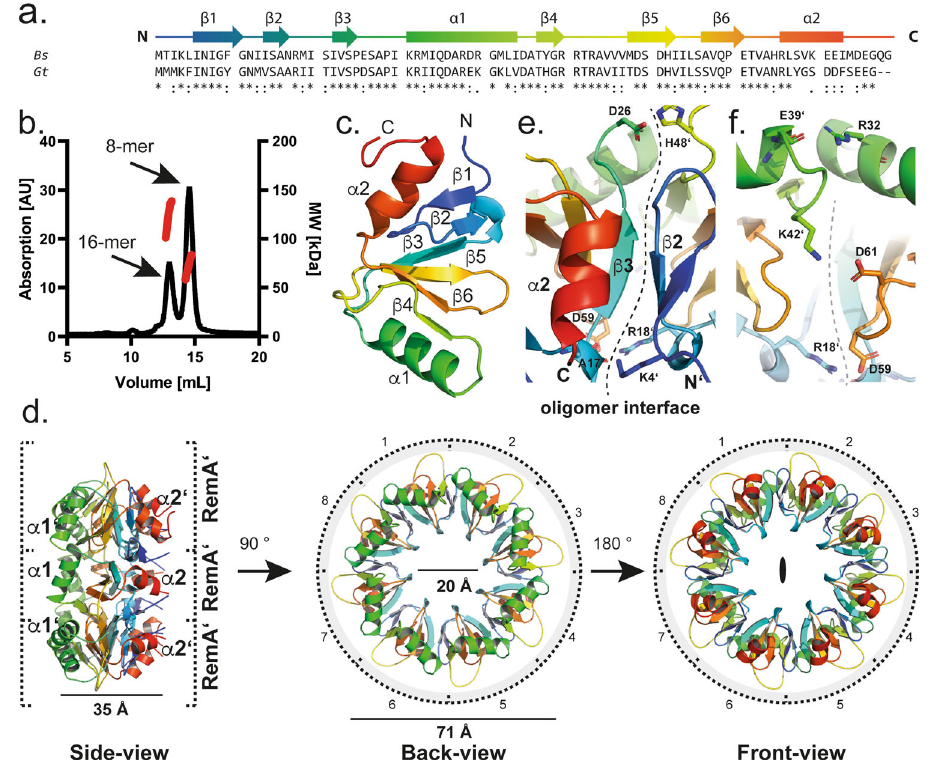
Fig. 1 Structure of the bio fi lm regulator RemA. a Amino acid sequence alignment of RemA from the Gram-positive model organism B. subtilis ( Bs ) and the moderate thermophilic bacterium G. thermodenitri fi cans ( Gt ). The secondary structural elements observed in the model are drawn schematically above the alignment and colored in rainbow colors from the N- to the C-terminus. b Chromatogram of the analytical SEC-MALS experiment of ( Gt )RemA at the protein concentration of 500 µ M. The absorption at a wavelength of 278 nm and the molecular weight (MW) calculated from MALS are in black and red, respectively. Source data are provided as a source data fi le. c Cartoon representation of a RemA monomer in rainbow colors from the N- to C-terminus (indicated by: ‘ N ’ and ‘ C ’ , respectively; PDB-ID: “ 7BM2 ” ). d Side, back, and front views of a (RemA) 8 . The color code is as in Fig. 1a, c. e - f Contact interface between two RemA subunits within (RemA) 8 . Further description is given in the main